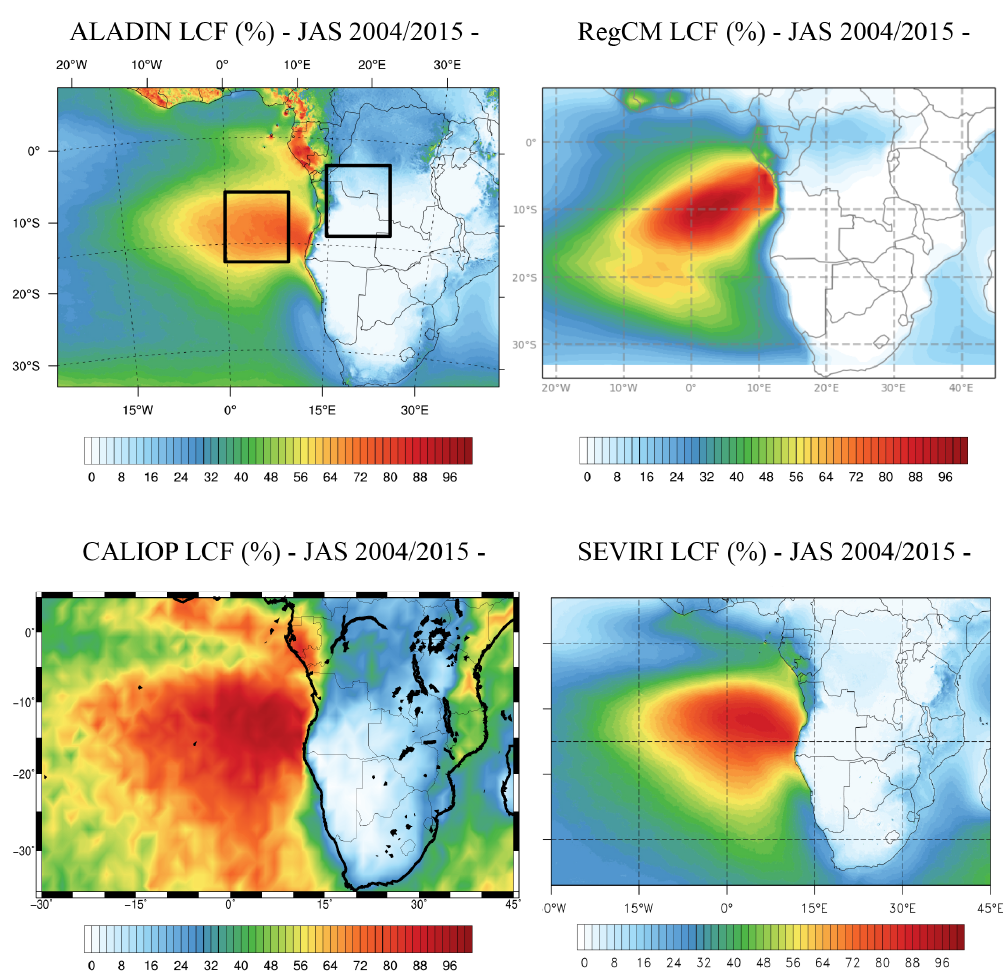
Figure 1. Seasonal (JAS) mean of the LCF (%) simulated for the ALADIN (2004–2015) and RegCM (2004–2015) models (CTL runs) and retrieved by the SEVIRI and CALIOP (2004–2015) instrument. The two different boxes (Box_0 and Box_S are indicated). The Box_0 (10–20 ◦ S, 0–10 ◦ E) has been defined by Klein and Hartmann (1993).